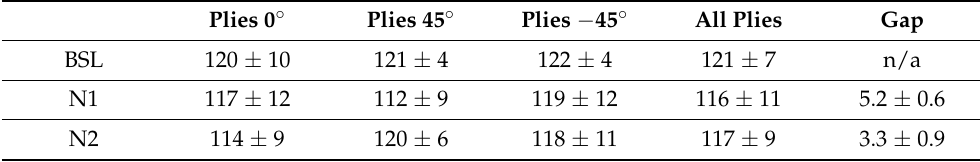
Table 1. Thickness of plies and interfacial gaps, mean, and standard deviation, µ m. Plies 0 ◦ Plies 45